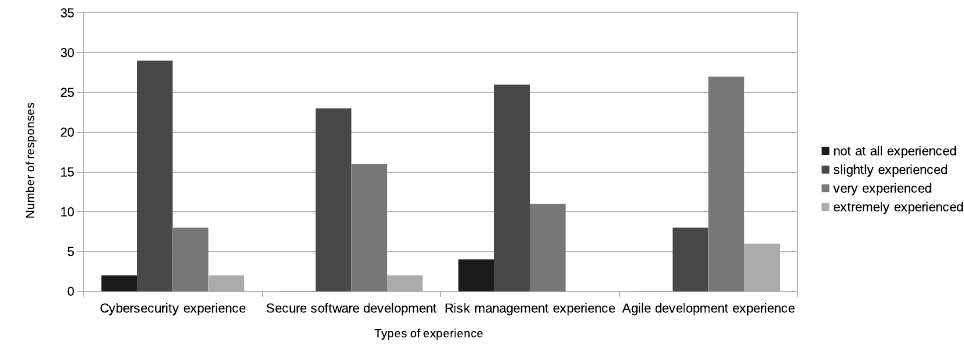
Figure 1. Clustered bar chart to show the cybersecurity self-assessment